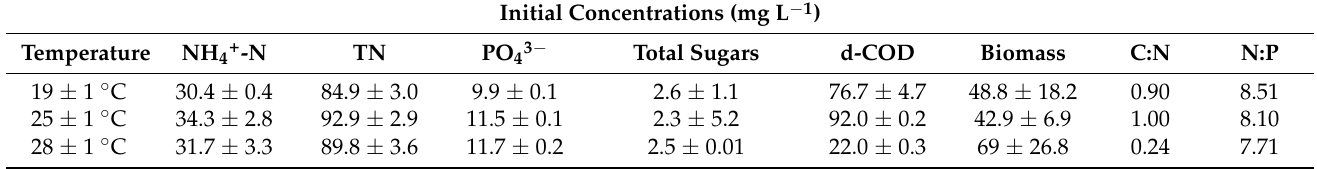
Table 7. Initial biomass and nutrient concentrations in the experimental sets for optimum temperature investigation.